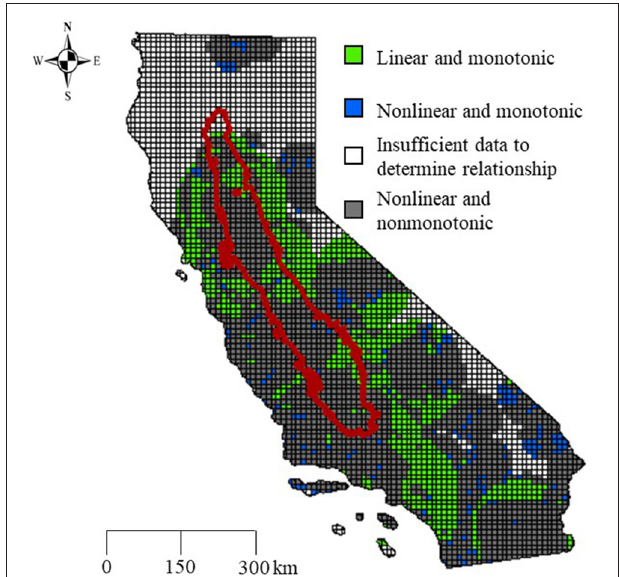
FIGURE 1 | TDS-depth relationship by grid sections in California. Areas with a linear ( R 2 > 0.8) and monotonic relationship are in green, non-linear ( R 2 < 0.8) and monotonic in blue, and insufficient data in white. Areas in gray have a non-linear non-monotonic TDS-depth